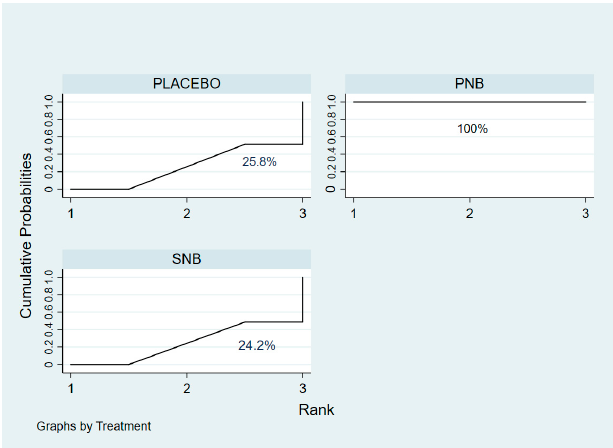
Figure 5. SUCRA ranking curves for prevention of ISP during the first 24 h after surgery. SUCRA, surface under the cumulative ranking curve; ISP, ipsilateral shoulder pain.